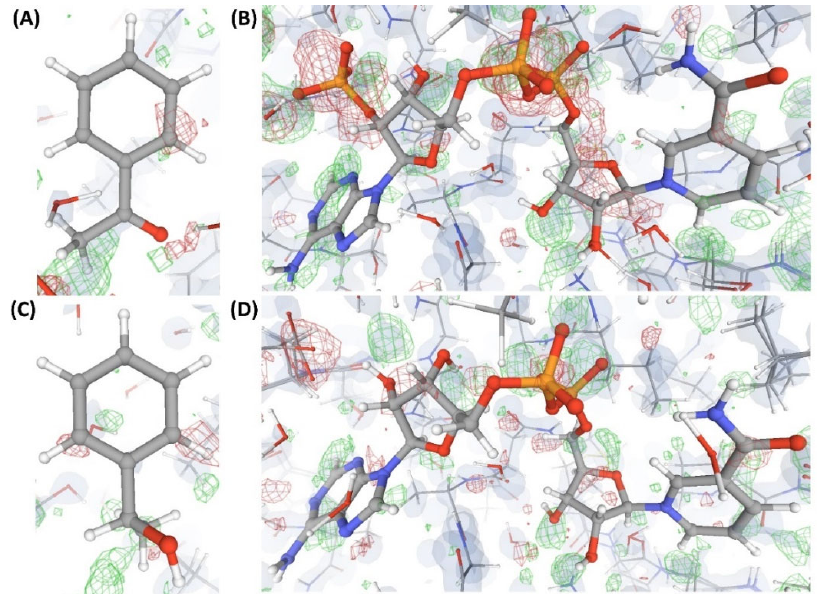
Figure 6. Electron density maps around the ligands (substrate and co ‐ substrate) bound to the structures (C5 and C6) discussed in case study ‐ 2. ( A ) L” in C5 (1.0 Å). ( B ) L5 in C5 (1.0 Å). ( C ) L’” in C6 (1.1 Å). ( D ) L6 in C6 (1.1 Å). For details on graphical representation styles and color codes of density maps, kindly refer to the legend of Figure 4.